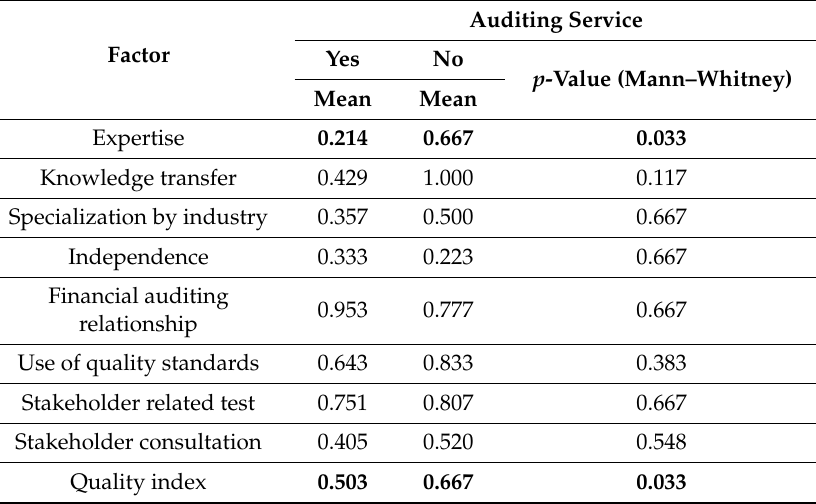
Table 14. Assurance quality vs. auditing